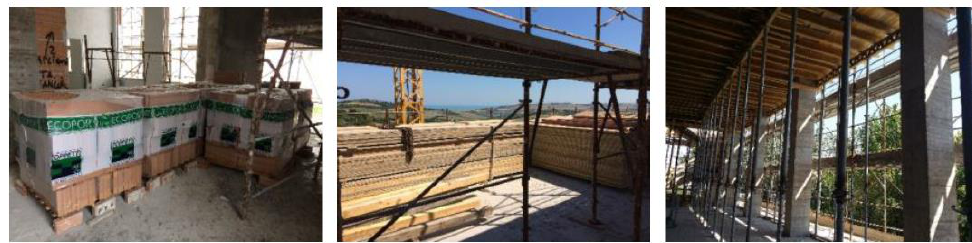
Figure 9. Examples of added mass considered in the FEM updating.